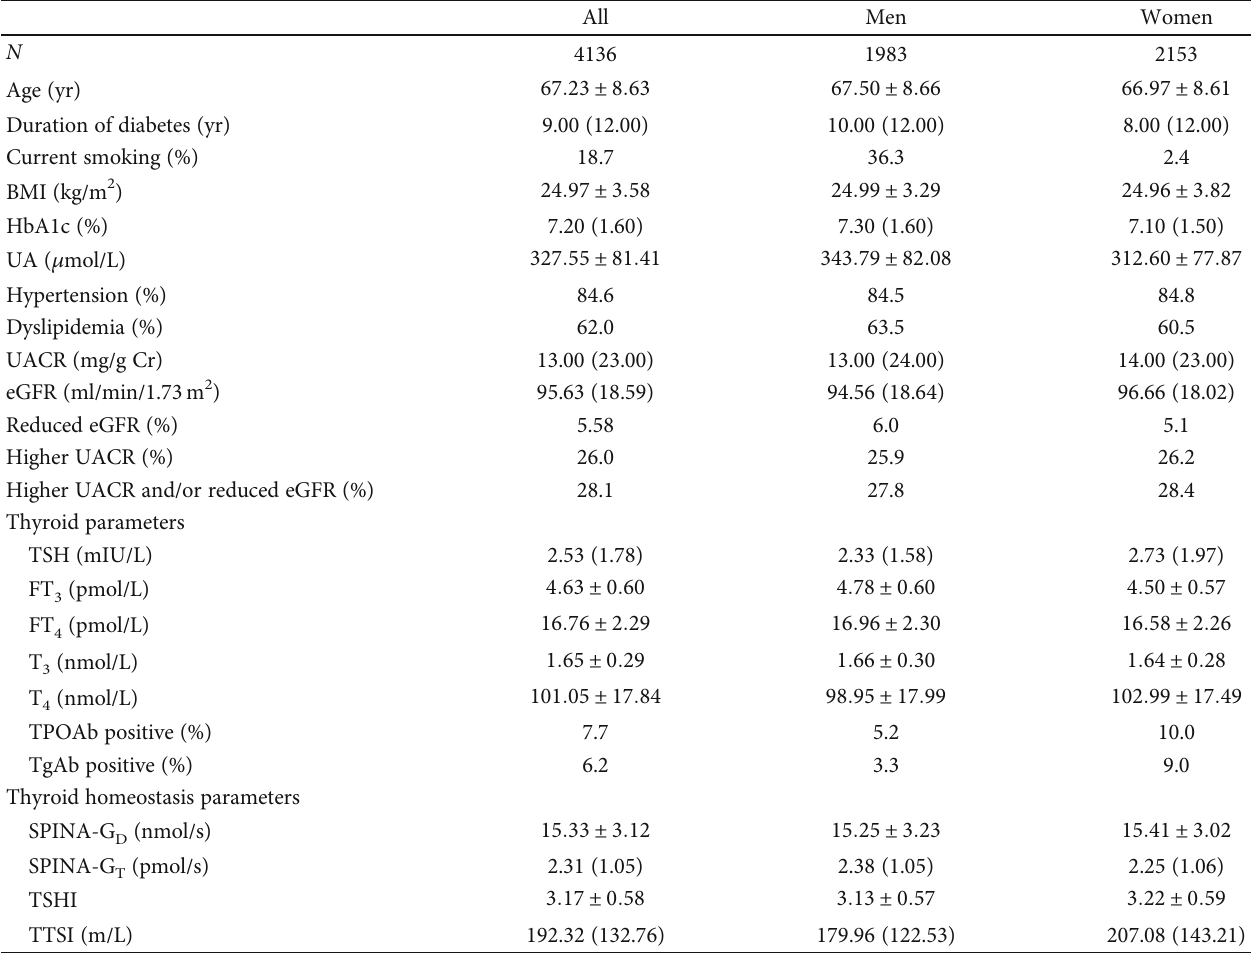
Table 1: Clinical characteristics of all